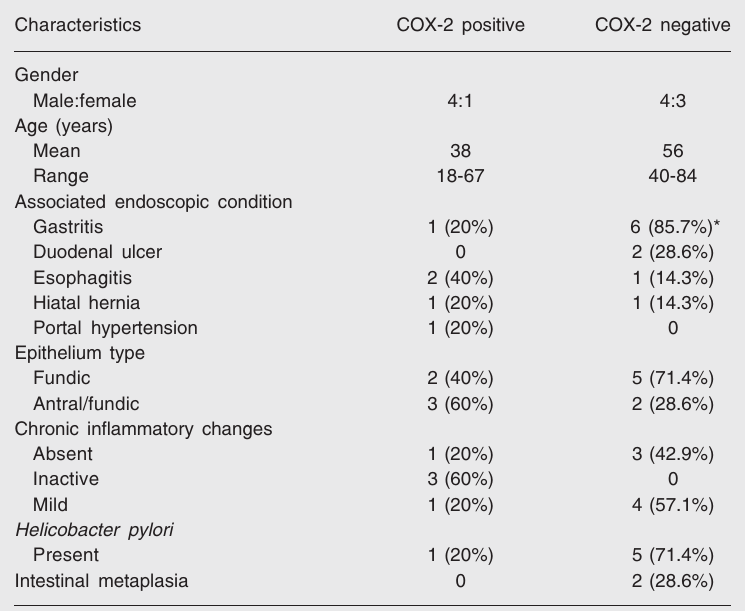
Table 3. Comparison of various characteristics of ectopic gastric mucosa